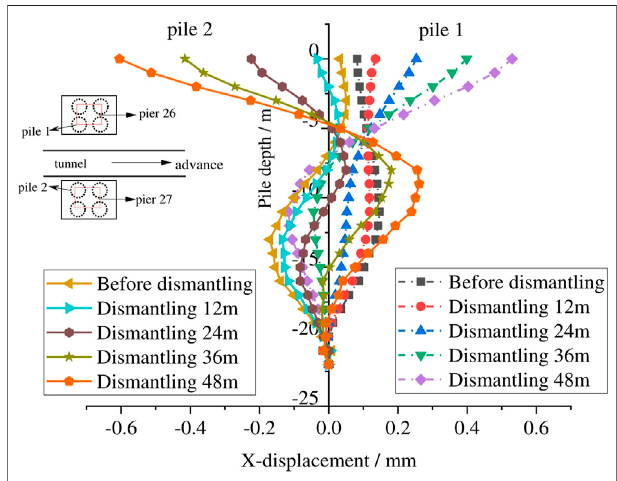
FIGURE 7 | Displacement of pile 1 and 2 in the X-direction during